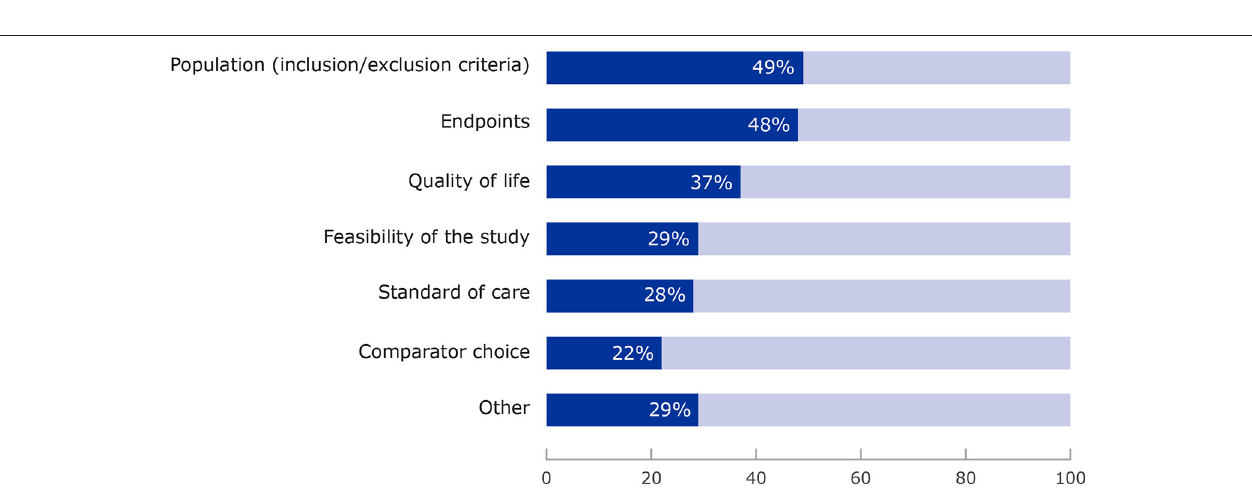
FIGURE 2 | Areas of development plan where patients provided input. More than one category could be selected for each survey